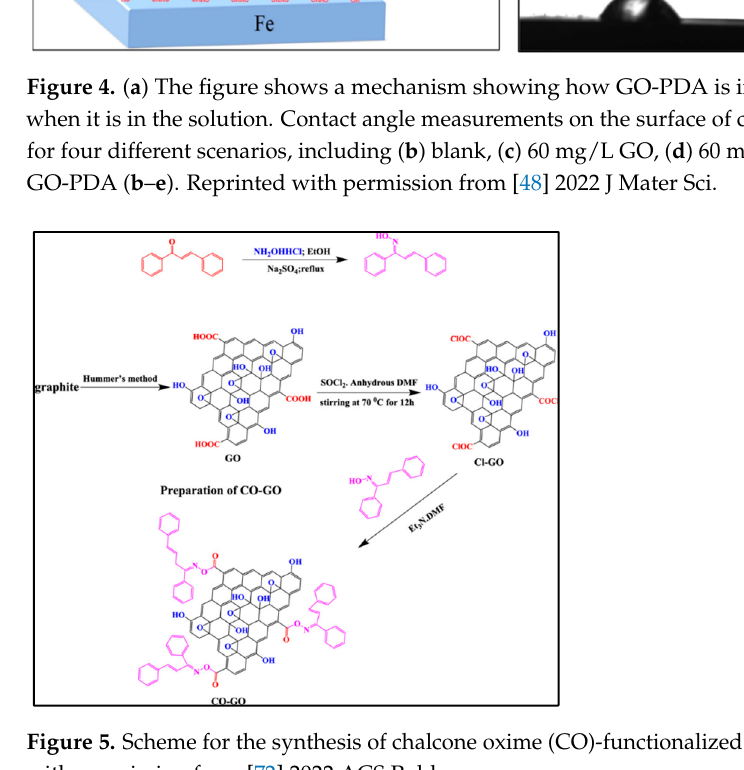
Figure 5. Scheme for the synthesis of chalcone oxime (CO)-functionalized graphene oxide. Re- printed with permission from [72] 2022 ACS Publ.